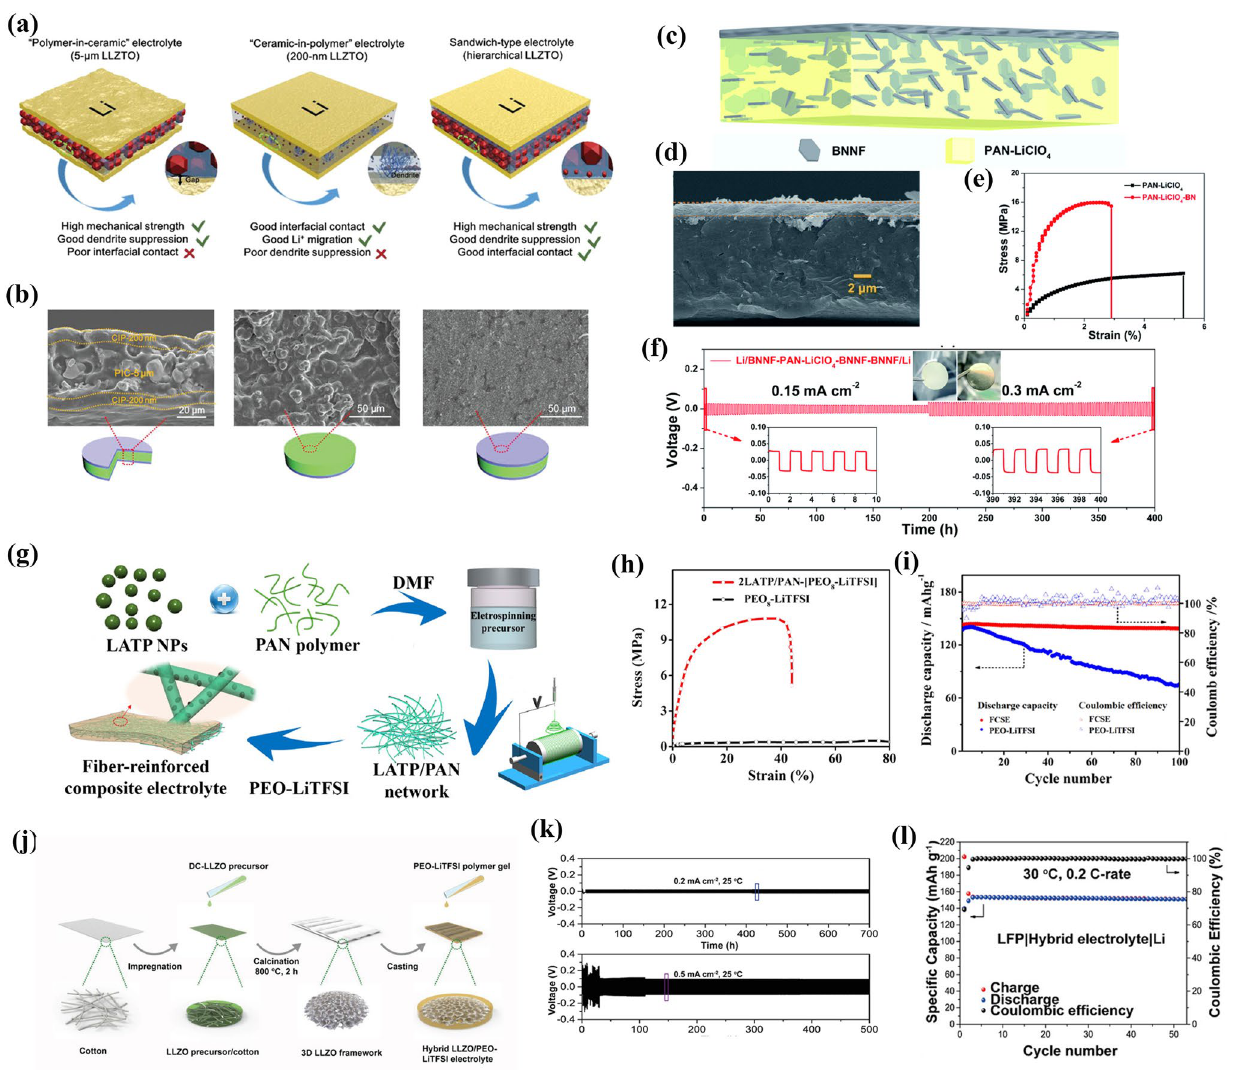
Fig. 17 a Description of the PIC-5 µm, CIP-200 nm, and hierarchical CPEs; b cross-sectional SEM pictures of LLZTO-PEO CPEs with hier- archical structure. Adapted with permission from Ref. [175]. c Schematic of the BNNF-PAN-LiClO 4 -BNNF; d cross-sectional SEM image of the BNNF-PAN-LiClO 4 -BNNF; e stress–strain curves of the PAN-LiClO 4 and BNNF-PAN-LiClO 4 -BNNF CPEs; f BNNF-PAN-LiClO 4 -BNNF CPEs and lithium metal anodes after cycles. Adapted with permission from Ref. [176]. g Schematic Illustration for the preparation of the LATP- PAN-PEO CPEs; h stress–strain curves of LATP-PAN-PEO CPEs and PEO8–LiTFSI; i cycling stability of Li|LATP-PAN-PEO CPEs|LiFePO 4 batteries at 0.2C. Adapted with permission from Ref. [177]. j Schematic illustration for the preparation of the LLZO-PEO CPEs. k Cycles of Li|LLZO-PEO CPEs|Li 0.1 and 0.2 mA cm − . 2 ; l Cycling performance of LiFePO 4 |LLZO-PEO CPEs|Li at 0.2C. Adapted with permission from Ref.